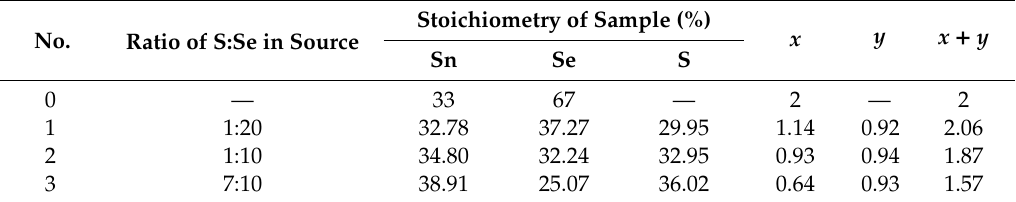
Table 1. Sample number and EDS results of SnSe x S y nanosheets